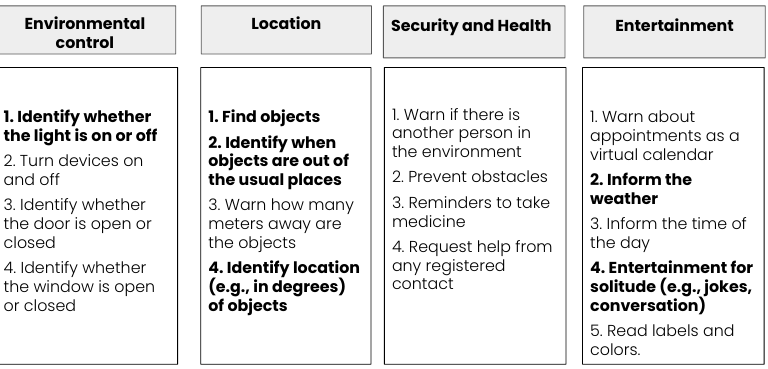
Figure 1. Features categories—the ones that are highlighted we